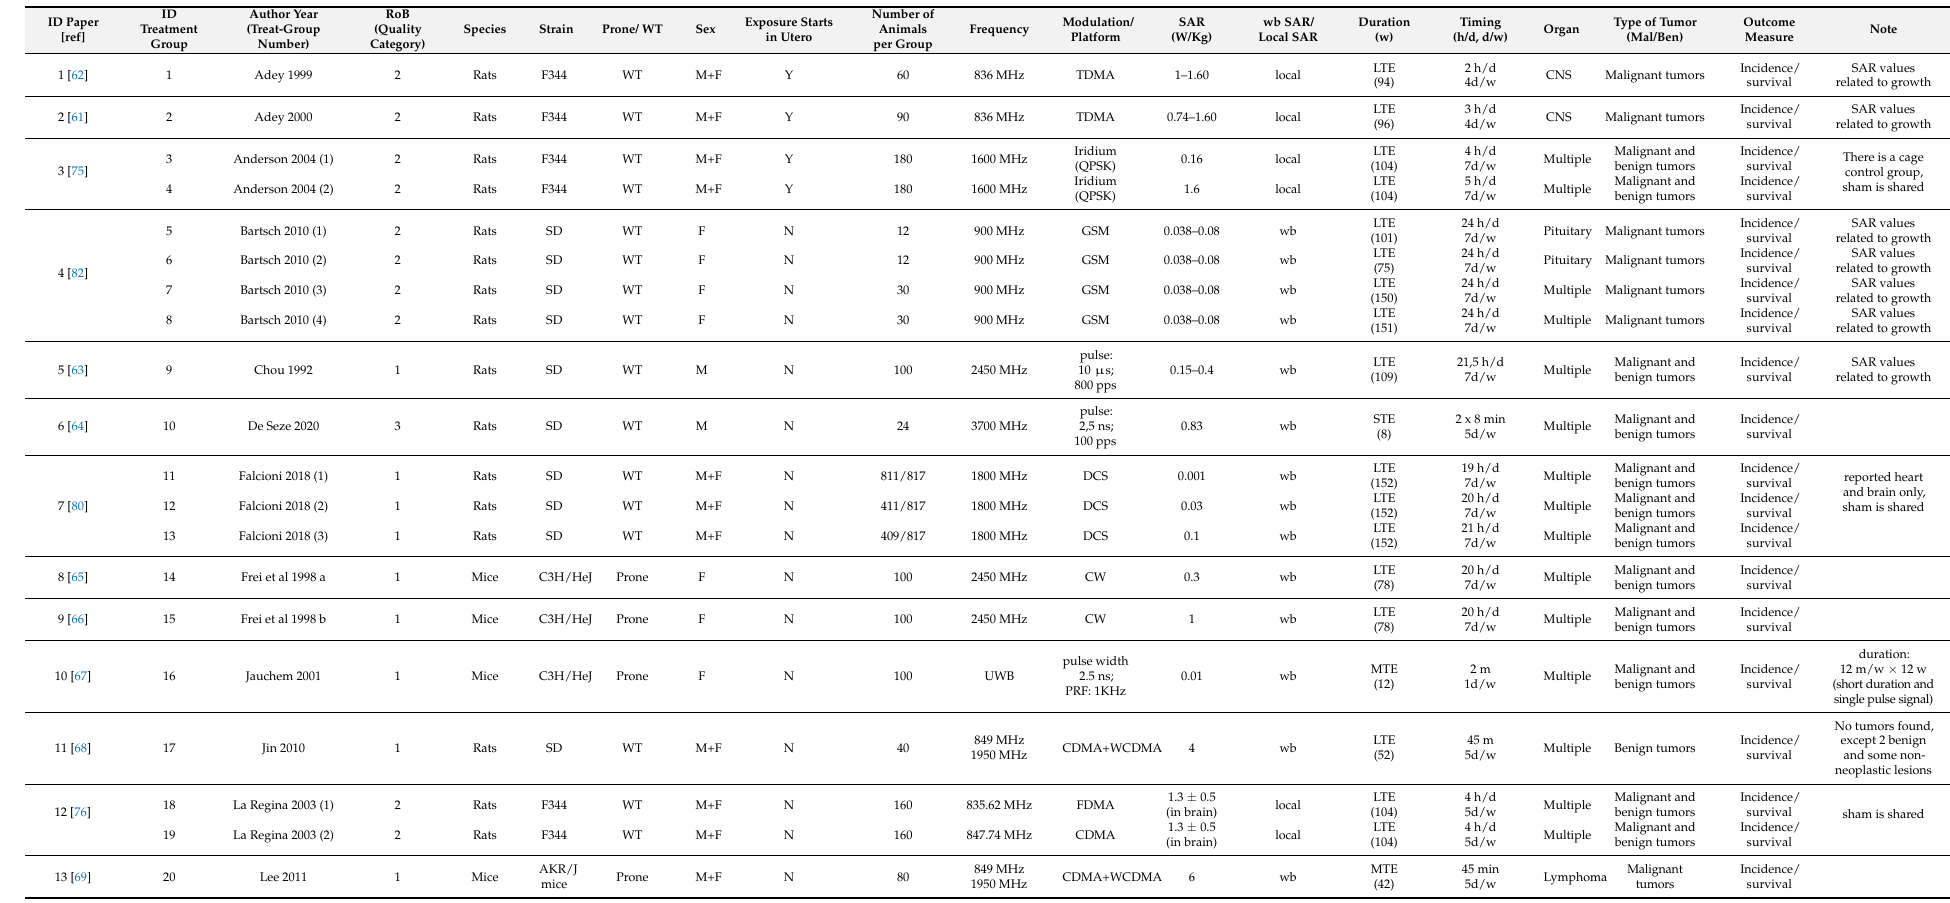
Table A1. Summary of the most relevant information of the 27 papers (66 treated-sham control comparisons) in terms of populations, exposure and